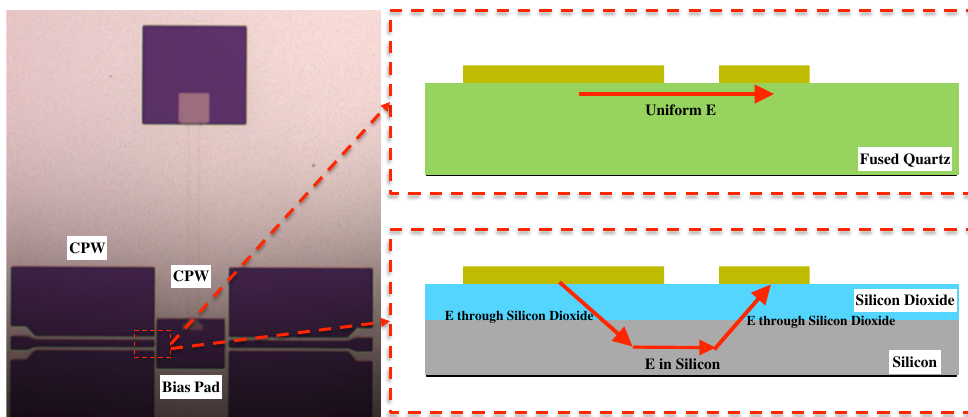
Figure 3. The strongest electric field is between the CPW and the adjacent DC bias